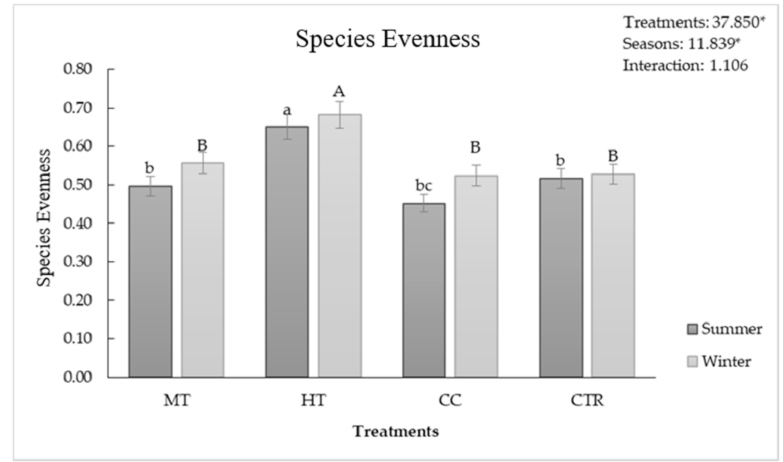
Figure 5. Species Evenness in soil under differently managed plots of Pinus laricio plantation. HT: intensive thinning; MT: moderate thinning; CC: clear cut; and CTR: control. Two-way ANOVA shows the effects of treatments, seasons, and their interactions. Lowercase letters and capital letters show significant differences among the management intensities (Tukey’s test, p -level ≤ 0.05) in summer and winter, respectively. * p < 0.05. The data are the means of two consecutive years (2014 and 2015). Table 5. Analysis of variance of the effects of treatments, seasons, and their interactions on arthropod parataxonomic units. * p < 0.05. F -Ratio Treatments